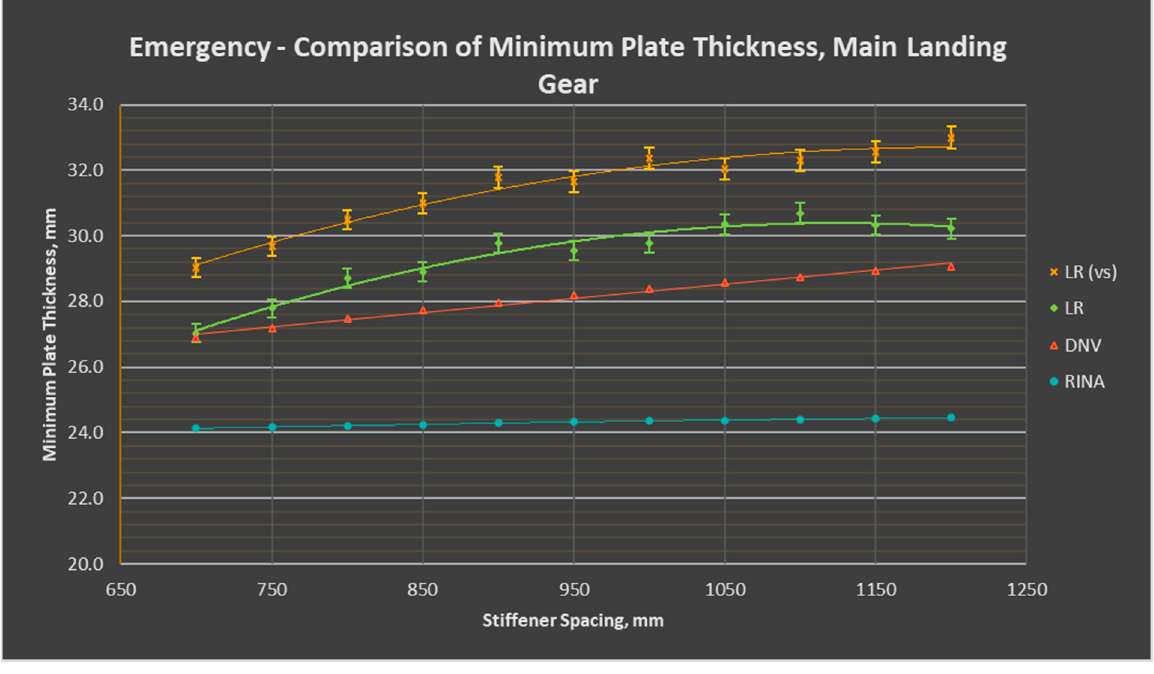
Figure 4. Variations in minimum deck plate thickness as a function of stiffener spacing required for the emergency condition (the notation LR (vs) refers to emergency conditions at a point on the deck above a vulnerable space, i.e., over magazines or permanently manned spaces).